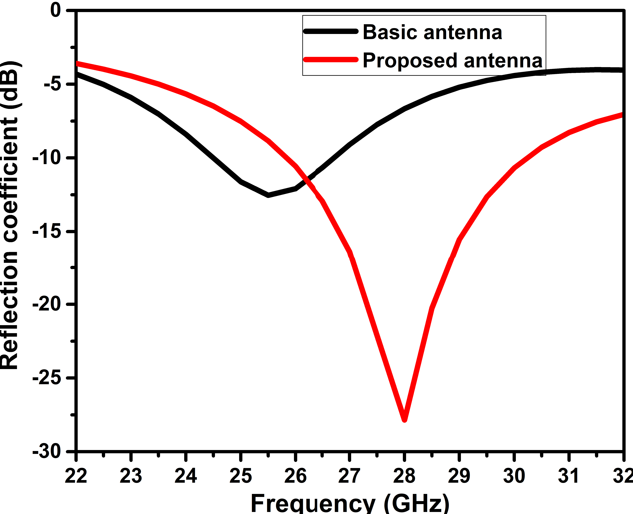
Figure 3. The design development stages of projected antenna ( a ) first stage ( b ) proposed antenna. Table 2. Antenna parameters in the design evolution process.